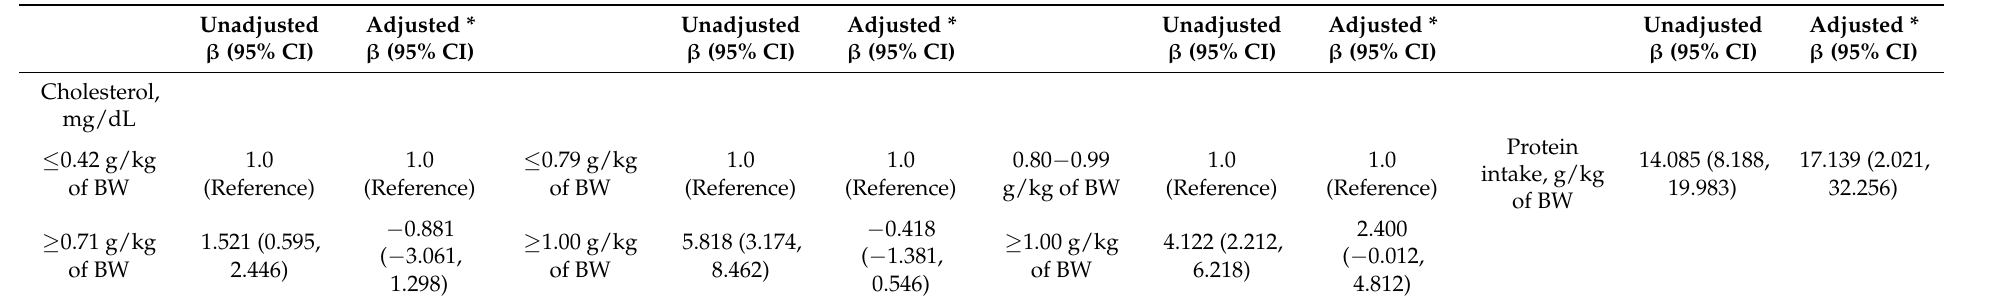
Table 4. Association between protein intake and total blood